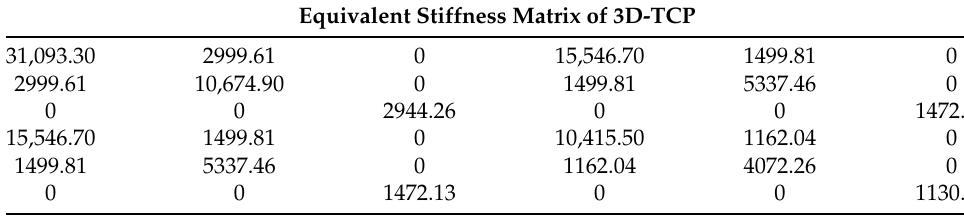
Table 3. Equivalent stiffness matrix of 3D-TCP (unit: